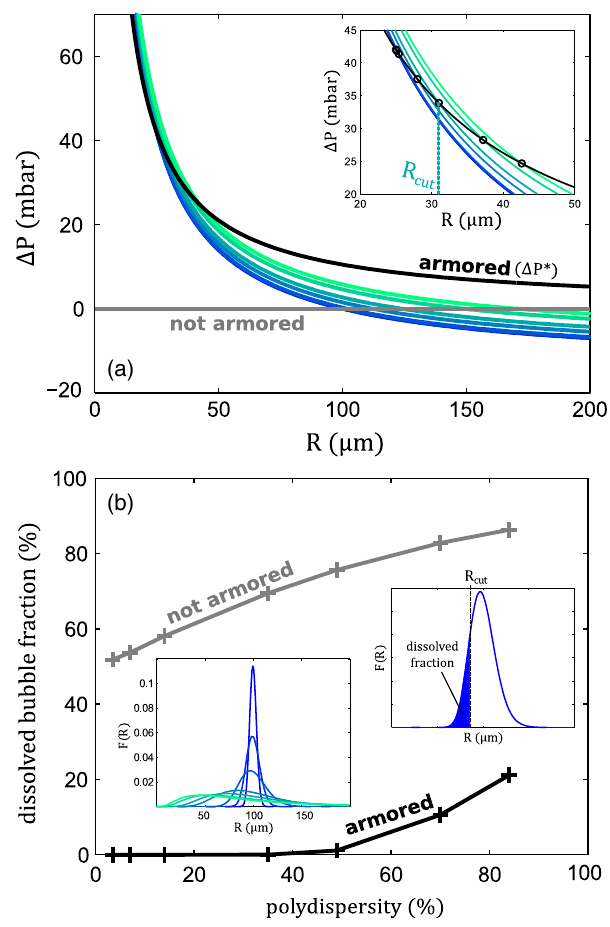
FIG. 5. (a) The blue-green curves display the overpressure felt by a bubble as a function of its inverse radius R in a foam with a log-normal bubble-size distribution. The mean of the distribution is kept constant at 100 μ m, while the standard deviation is varied from 3 . 5 μ m (blue) to 84 μ m (green), as shown in the lower inset. The black line represents the resistance Δ P (cid:3) of a colloidal shell as defined by our model and our experiments. Bubbles subjected to a pressure below this critical value will collapse and disappear, while the others will remain stable. The case of unarmored bubbles ( Δ P ¼ 0 ) is displayed in gray for compari- son. The inset is a close-up of the region where Δ P ¼ Δ P (cid:3) ( ∘ ), which defines the cutoff radii R . (b) The percentage of bubbles cut that collapse or dissolve under the influence of the whole foam, in the armored case (black) and the unarmored case (gray). The polydispersity is calculated as the standard deviation of the distribution divided by the mean. The buckled percentage is calculated by integrating the probability density function on ½ 0 ; R (cid:2) , as shown in the right inset. The left inset shows the cut probability density functions F ð R Þ used for the calculations, with increasing